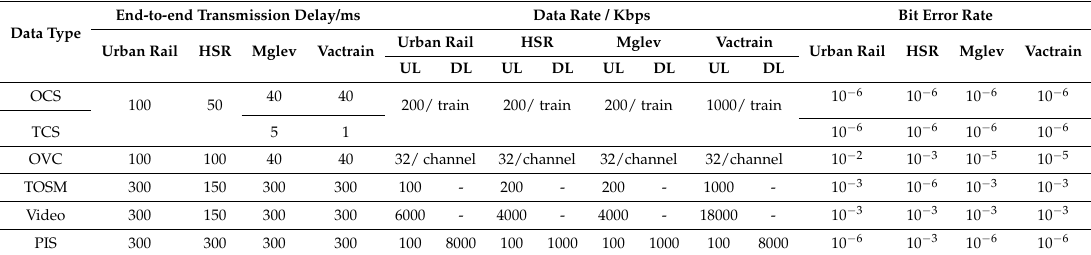
Table 2. Train-to-ground wireless communication performance